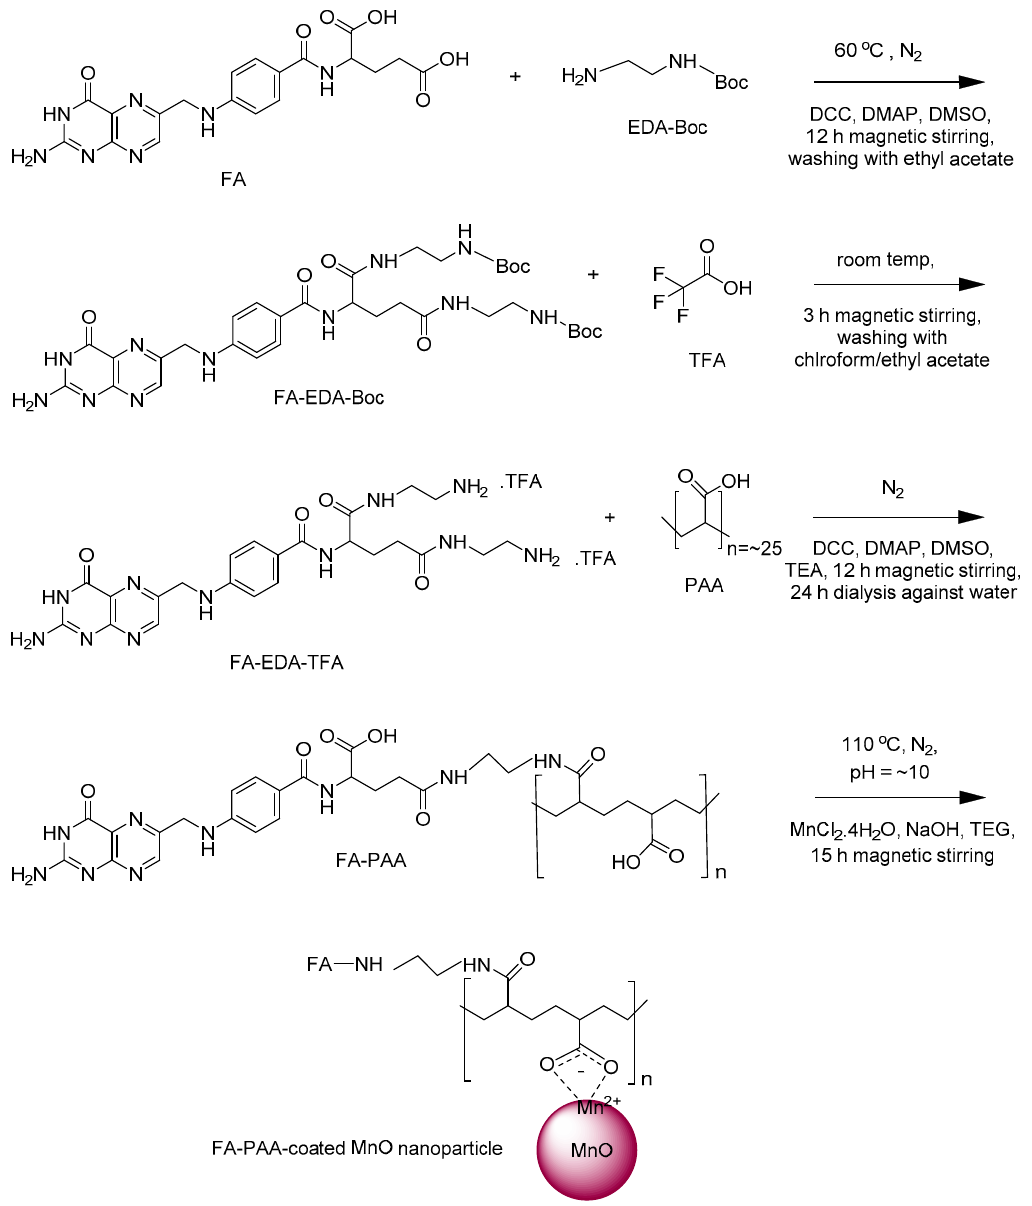
Figure 1. Synthesis of folic acid-polyacrylic acid (FA-PAA) via three steps and the FA-PAA-coated manganese oxide (MnO) nanoparticles via one-step.